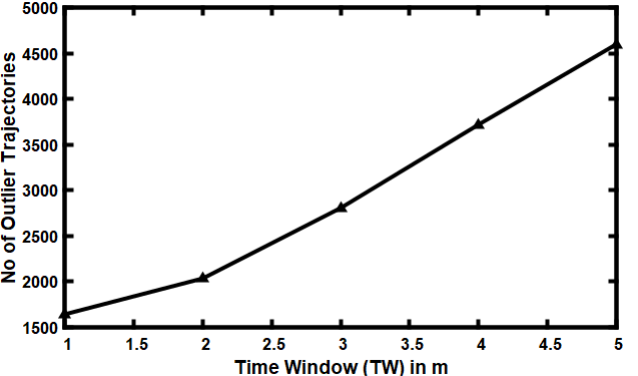
Figure 8. Effects of varying the time window (TW) on the number of discovered outliers’ trajectories. The impacts of varying the time window (TW) scale is measured against the number of iterations required before finding outliers trajectories. As illustrated in Figure 9, the X-axis indicates the time window (TW) in minutes, and the Y-axis shows the number of checks needed to detect outlier trajectories. Both the maximum and the mean rounds required to discover outlier trajectories are measured. As seen in Figure 9, the number of rounds for discovering outliers’ trajectories decreases by increasing the duration of the time window (TW). Increasing the size of the time window requires a small number of re-examinations to discover outliers’